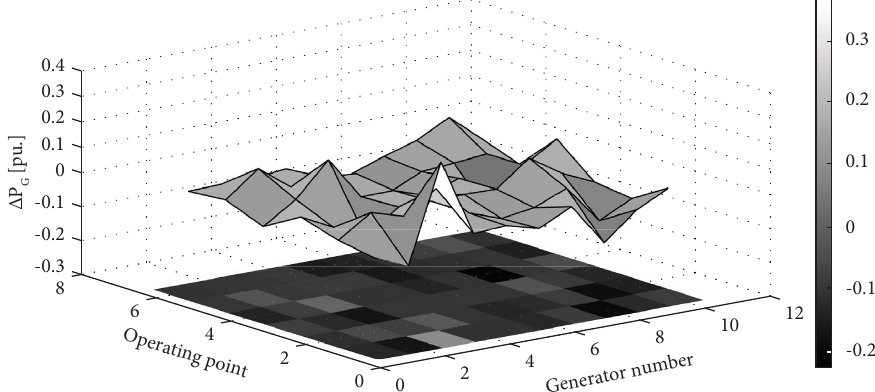
Figure 5: Generator power change limits at diferent operating points for IEEE 39-bus system.